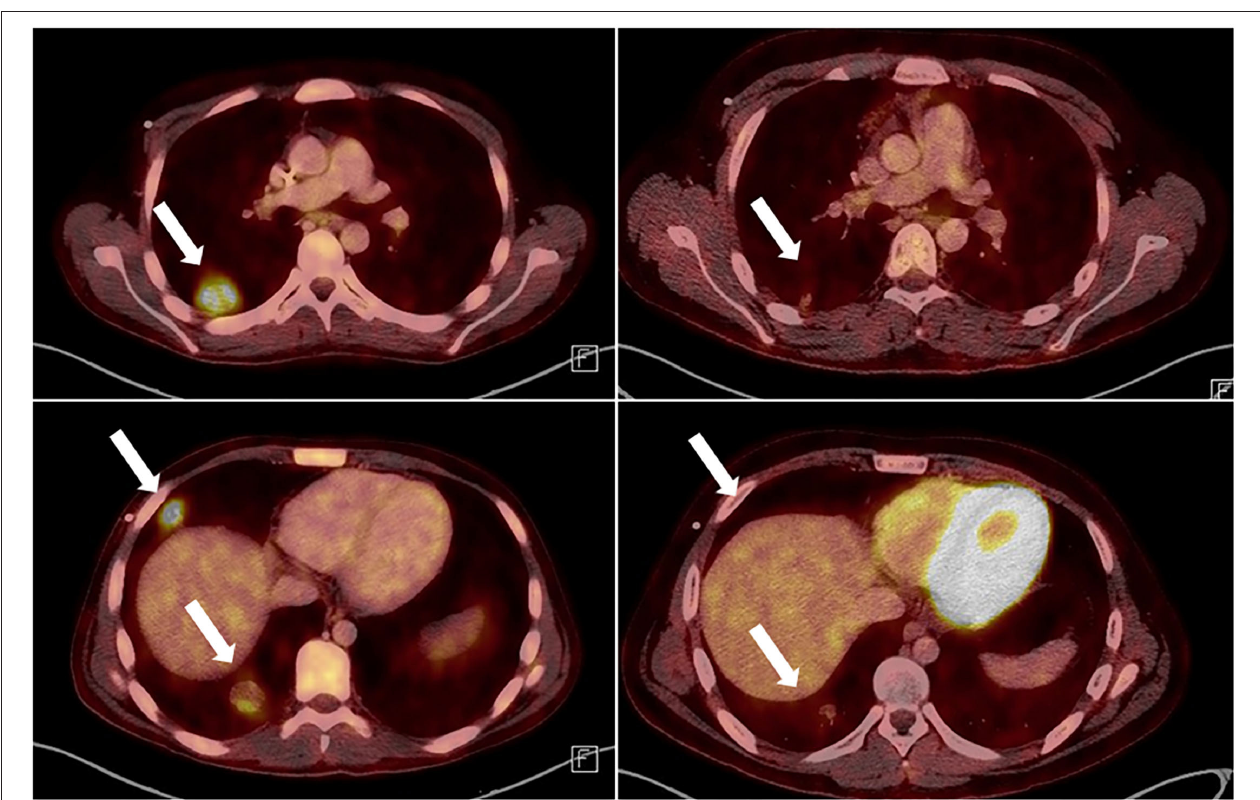
FIGURE 1 | Thoracic FDG-PET CT prior to treatment (left side) and after 5 cycles or Rituximab (right side) . Lesions marked with arrows. The luminous structure in the lower right picture is the left ventricle, which shows an increased metabolism compared to the right picture, because it is contracting. This FDG-PET accumulation has nothing to do with the metabolism of the tumor